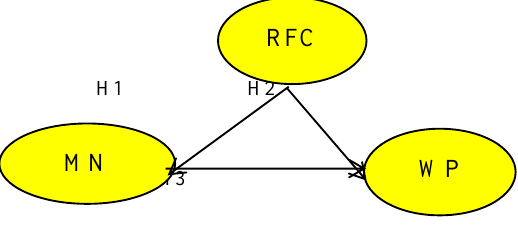
Figure 1: Research Model; Note: RFC (readiness for change); MN (mindfulness): WP (work